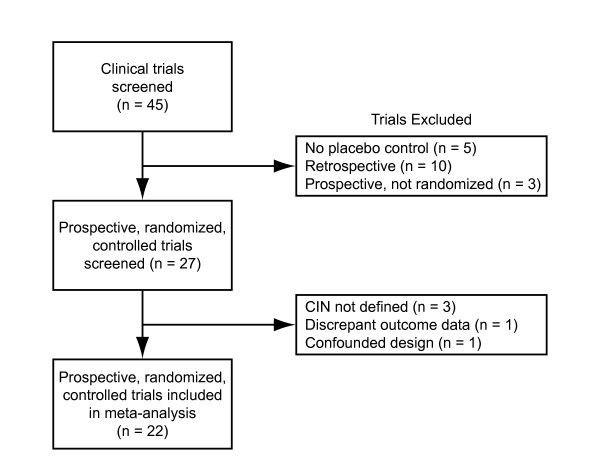
Study selection flow diagram.